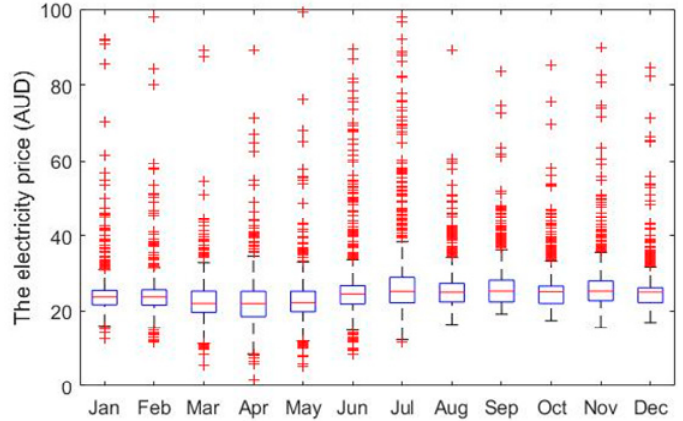
Figure A1. The box chart of monthly electricity Figure 1. The box chart of monthly electricity prices.